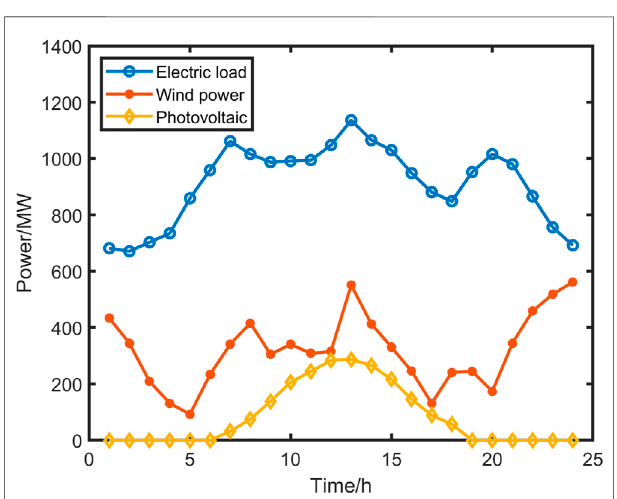
FIGURE4| Typicalpowercurvesofwindpower,photovoltaicandelectricalloads.